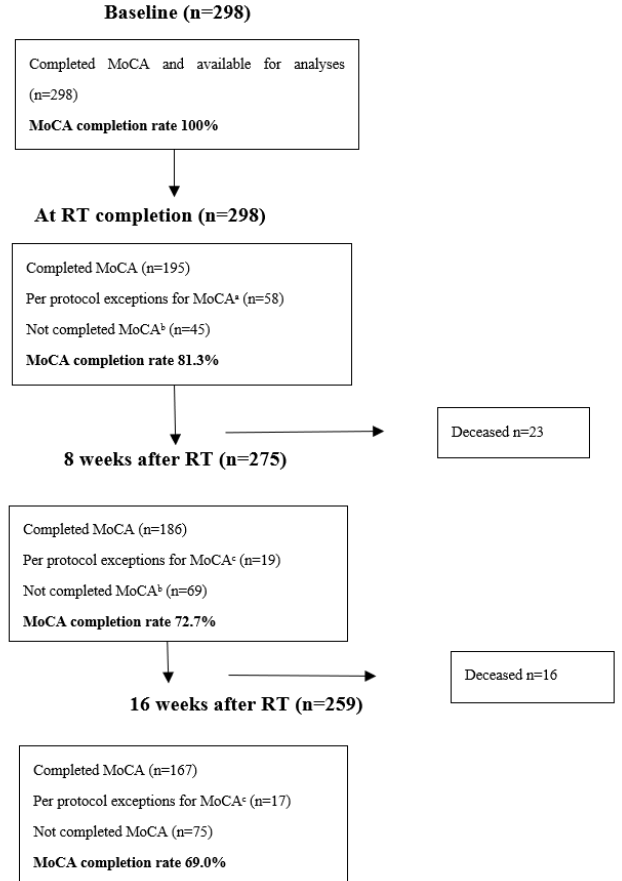
Figure 1. Patient flow chart and MoCA completion rates. ᵃ Patients receiving ≤ 9 fractions, per pro- tocol, did not perform the MoCA test at the time of RT completion. ᵇ Excluding per protocol excep- tions and deceased patients. ᶜ Patients alive at time of assessment and recruited from municipali- ties that did not participate in performing the mGA during follow-up.